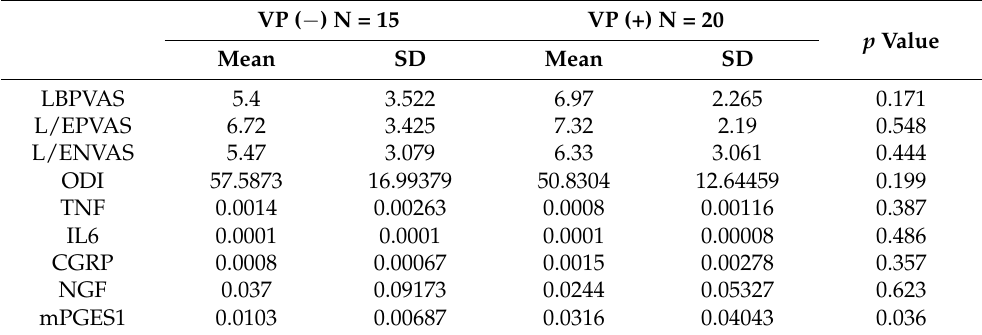
Table 3. Comparison of clinical findings and the expression of pain-related molecules between the vacuum phenomenon (+) and ( − ) groups.